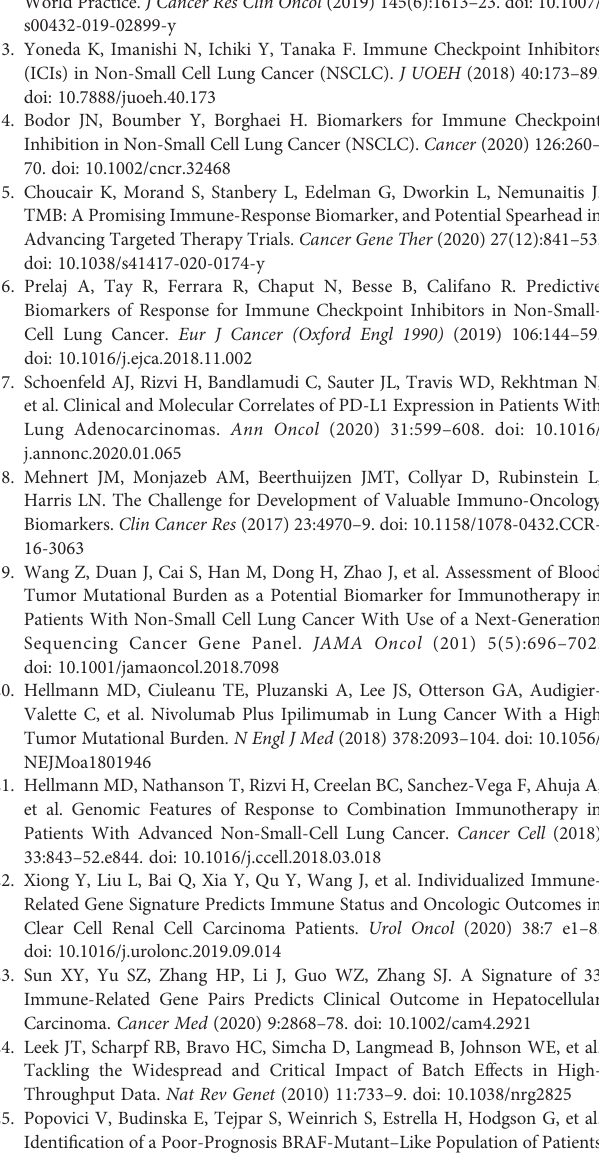
Supplementary Figure 4 | Association of BRGPI and PD-L1 for NSCLC patients treated withanti-PD-1 immunotherapyintheCICAMScohort. (A) ROCanalysisofPD- L1expression for progression-free survival. (B) Kaplan-Meier survival curve of progression-free survival for NSCLCpatients treated with anti-PD-1 immunotherapy classi fi ed byPD-L1status. (C,D) Kaplan-Meier survival curveof progression-free survivalforNSCLCpatientswith (C) andwithout (D) positivePD-L1expressionbased on the BRGPI after anti-PD-1 immunotherapy. (E) Kaplan-Meier survival curve of progression-free survival for NSCLCpatients treated with anti-PD-1 immunotherapy amongsubgroups categorizedby BRGPI